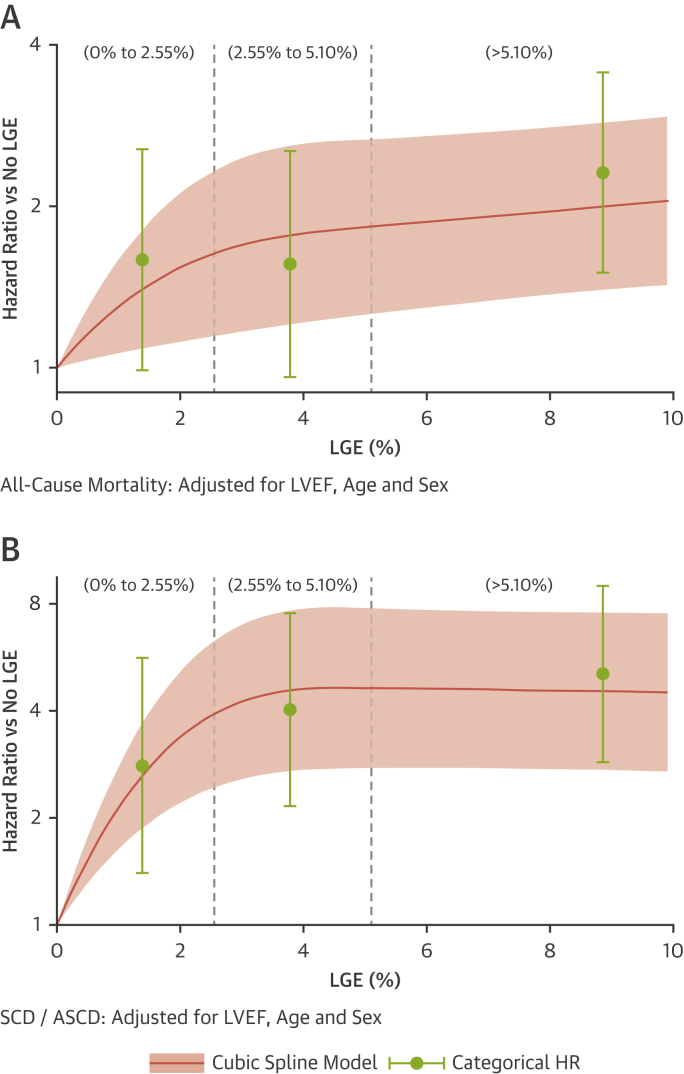
Outcome and Extent of Late Gadolinium EnhancementEstimated adjusted hazard ratios with 95% confidence intervals (green lines) for (A) all-cause mortality and (B) the sudden cardiac death endpoint, per group based on late gadolinium enhancement extent (LGE). Patients are divided into 3 groups based on cut-offs of LGE extent: >0 and <2.55%, ≥2.55 and <5.10%, and ≥5.10%. The hazard ratios for the endpoint are positioned at the median LGE extent within each group. A cubic spline model (orange line) has been fitted to the observed data. LVEF = left ventricular ejection fraction; SCD = sudden cardiac death; ASCD = aborted SCD.